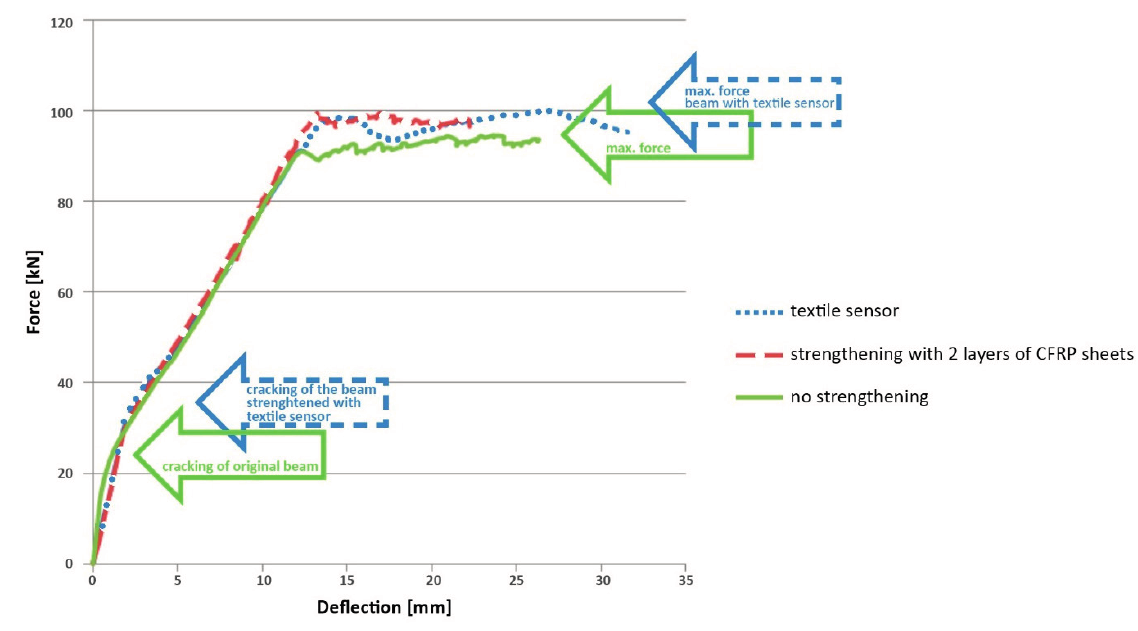
Figure 12. Relation between the external load and deflection for the three model beams: without strengthening, with carbon fiber reinforced polymer (CFRP) strengthening and with textile sensor strengthening.